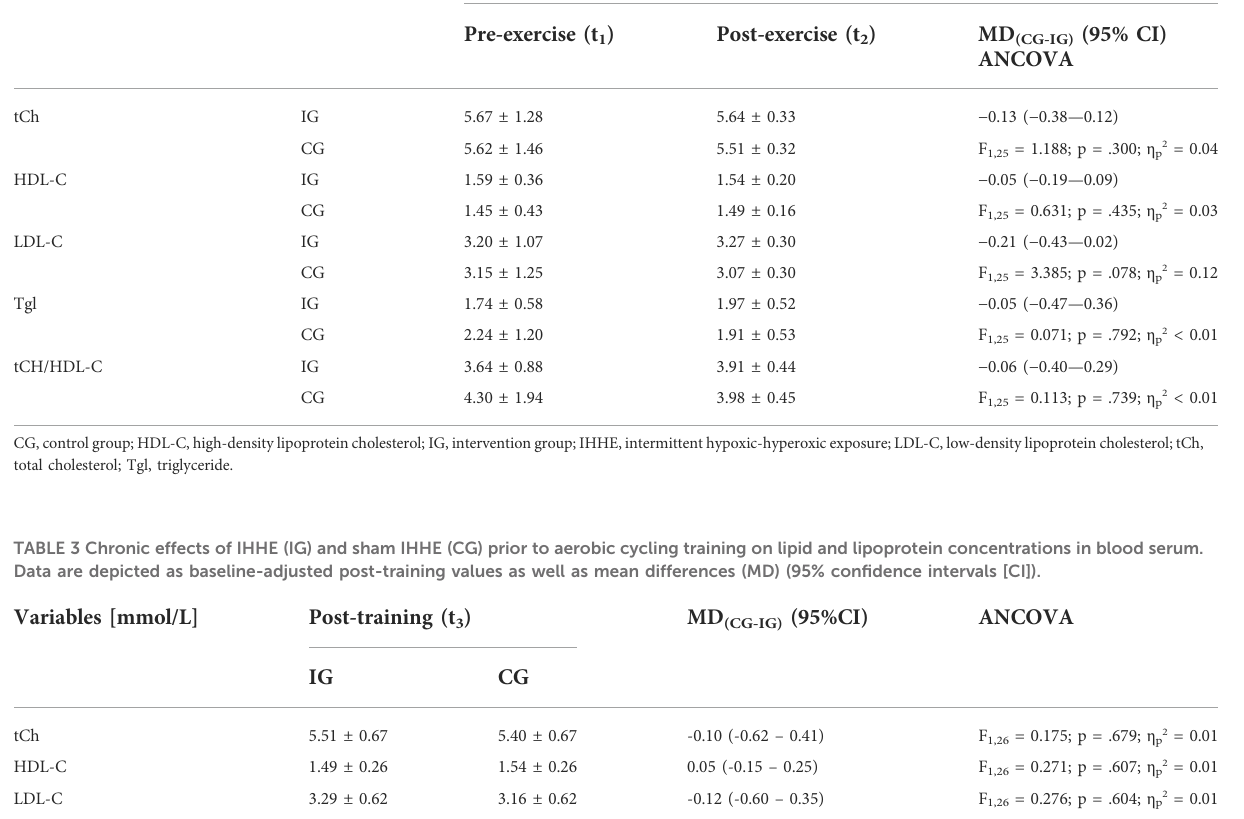
TABLE2AcuteeffectsofIHHE(IG)andsham-IHHE(CG)priortoaerobiccyclingexerciseonlipidandlipoproteinconcentrationsinbloodserumatthe fi rst and the last (18th) training session. Data are depicted as pre-exercise and baseline-adjusted post-exercise values (means ± standard deviations) as well as mean differences (MD) (95% con fi dence intervals [CI]). Variables [mmol/L]